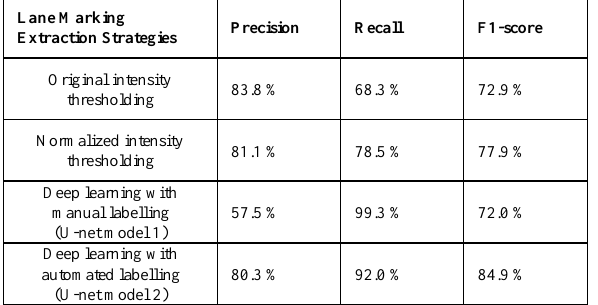
Table 4. Performance metrics in asphalt pavements for lane marking extraction strategies